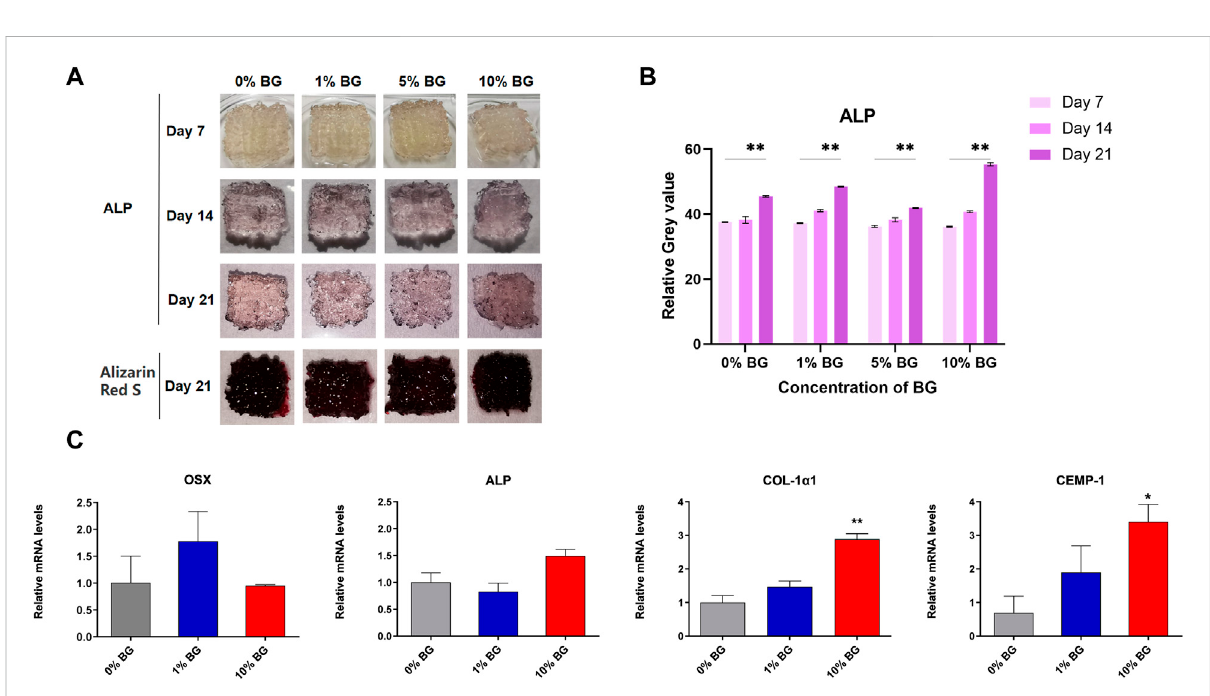
FIGURE 7 Osteogenic/cementogenic differentiation of HPDLCs on the biomimetic BG/GelMA scaffolds (A) Human periodontal ligament cells HPDLCs were cultured in macroporous BG/GelMA scaffolds in vitro . Alkaline phosphatase and alizarin red staining were performed every week. Photos of scaffolds on days 7, 14, and 21 were shown. (B) The Quantitative analysis of ALP staining. **** p < 0.01. n = 3 for each group. (C) The osteogenic and cementogenic quanti fi cation and gene expression of HPDLCs seeded on scaffolds 0% BG, 1% BG, and 10% BG for 7 days. n = 3 for each group. ** p < 0.01, * p <